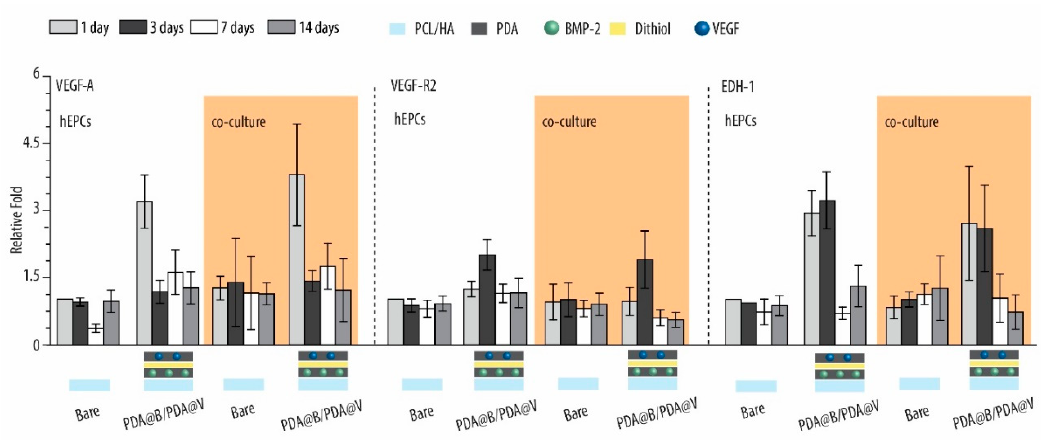
Figure 8. qRT-PCR analysis to assess the expression of angiogenic markers in human endothelial progenitor cells (hEPCs) and the co-culture of hEPCs and human mesenchymal stem cells at a 50:50 seeding ratio: PCL/HA-composite scaffolds contain a PDA@B/PDA@V surface coating consisting of two polydopamine (PDA) layers connected by a dithiol linker and entrapping BMP-2 (B) and VEGF (V) growth factors within the first and second PDA layers, respectively.